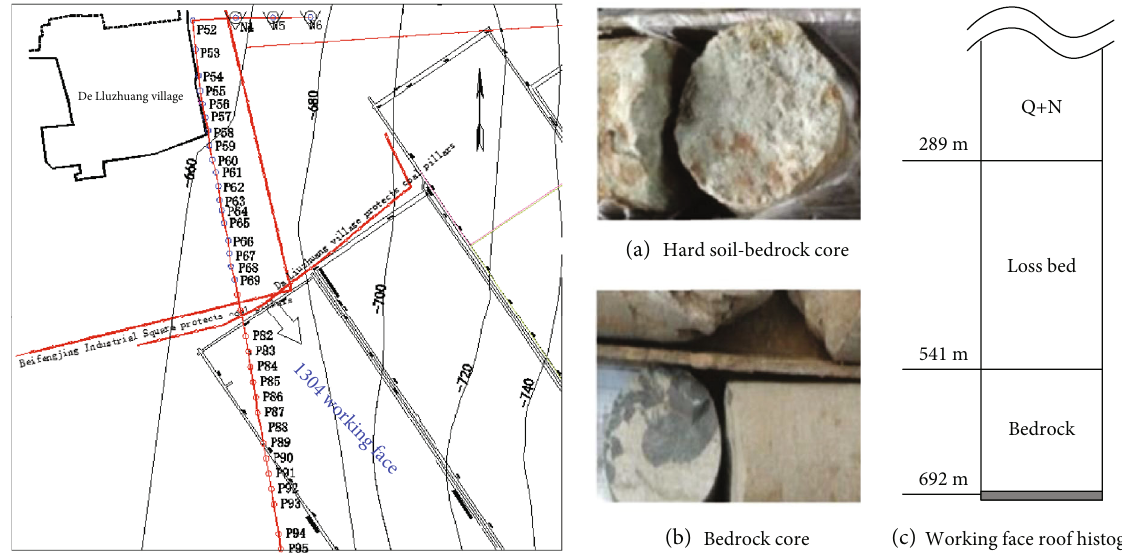
Figure 20: Working surface formation